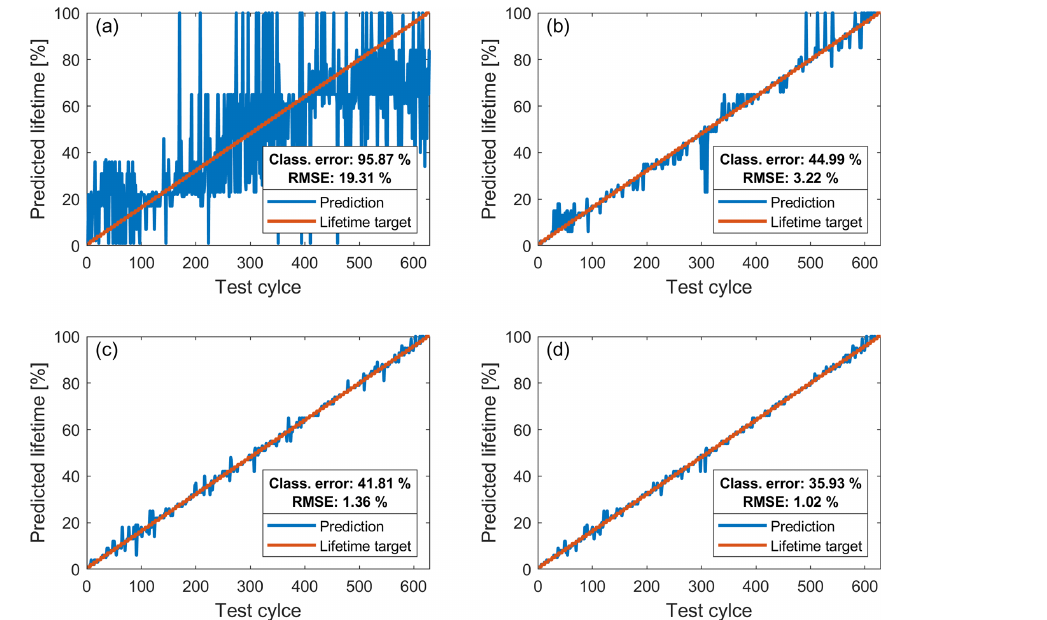
Figure 15. Predictions (blue) of the used EMC lifetime (steps of 1%) for one fold of the 10-fold cross validation for the data set with time shifts of up to 1 ms and the assumed used lifetime target from 1% to 100% (red). (a) Model trained with raw data only using both amplitude and phase features. (b) Model trained with raw data only using only amplitude features. (c) Model trained with raw, 0.1, and 0.5ms time-shifted data sets using both amplitude and phase features. (d) Model trained with raw, 0.1 and 0.5ms time-shifted data sets only using amplitude